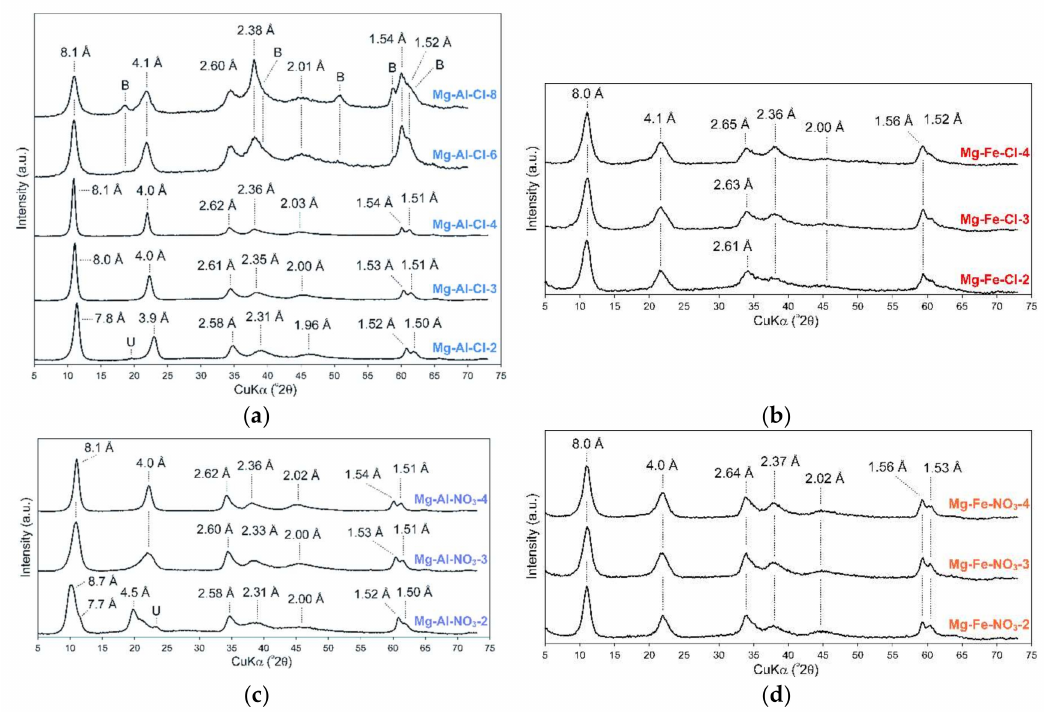
Figure 2. XRD patterns of raw LDH materials: ( a ) Mg-Al-Cl, ( b ) Mg-Fe-Cl, ( c ) Mg-Al-NO 3 , and ( d ) Mg-Fe-NO 3 , (B—brucite,